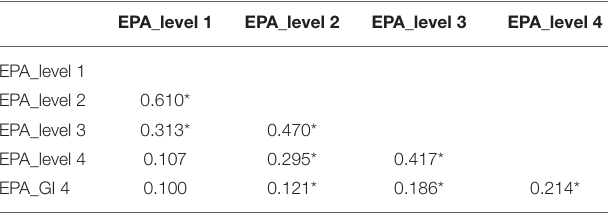
TABLE 9 | Association Co-efficients general EPAs-GI EPA 4 for